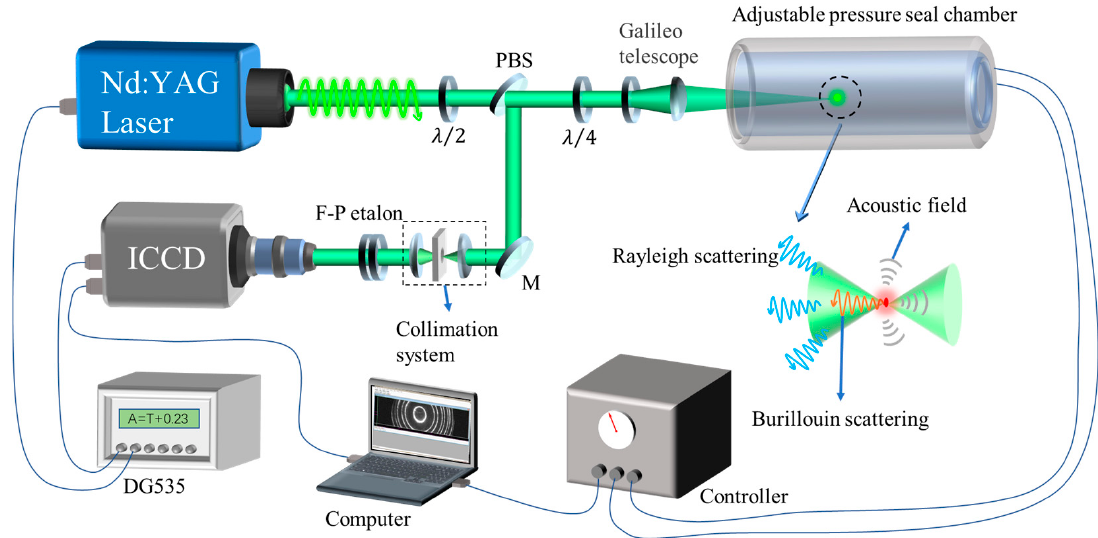
Figure 1. Optical setup of SBS lidar. λ /2 is a half-wave plate, λ /4 is a quarter-wave plate, and PBS is a polarization beam splitter.